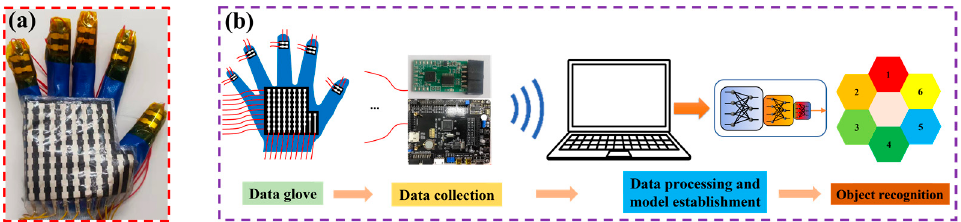
Figure 12. The process of object recognition. ( a ) The data glove with integrated sensors; ( b ) the object recognition system.